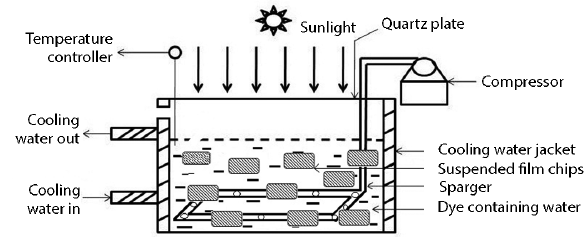
Figure 2. FESEM image of the iron-doped ZnO NPs (Roy et al., 2016)